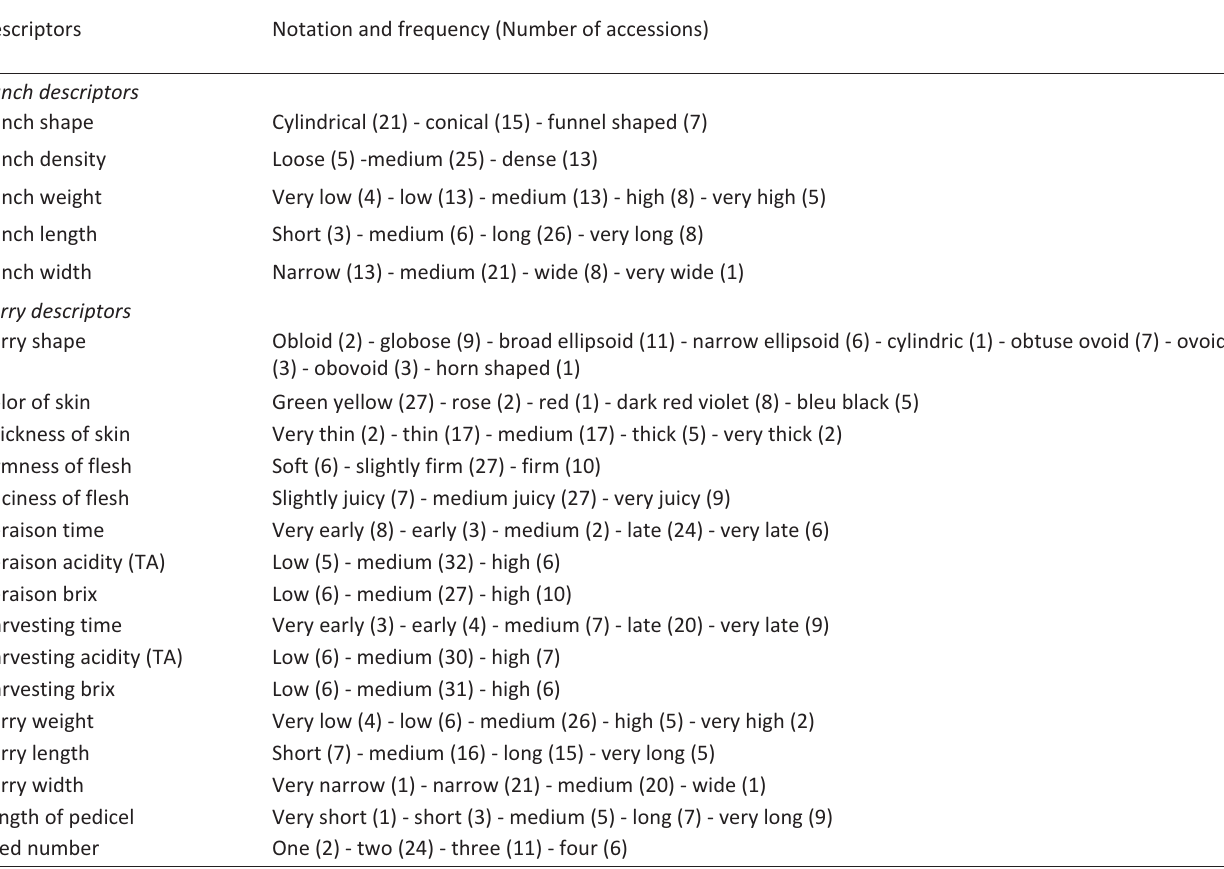
Table 5 ­ Bunch and berry descriptors notation and their frequency distribution among the 43 studied grapevine